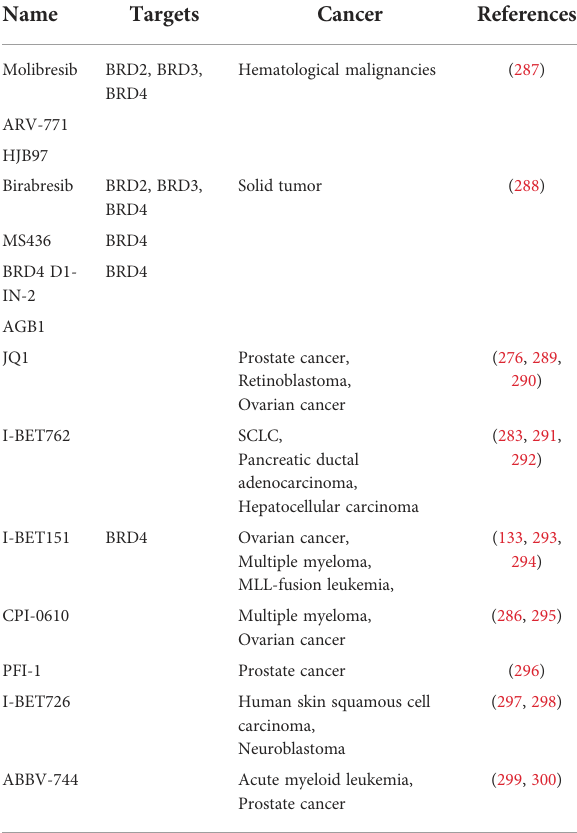
TABLE 6 Targets of BET inhibitors and related